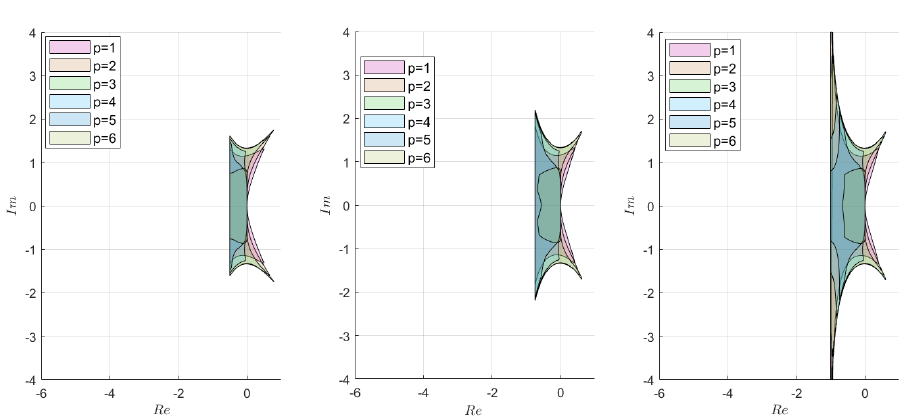
Figure 1. Stability regions of Adams–Bashforth–BDF semi-explicit methods with k = [ 0,0.5,1 ] (from left to right).